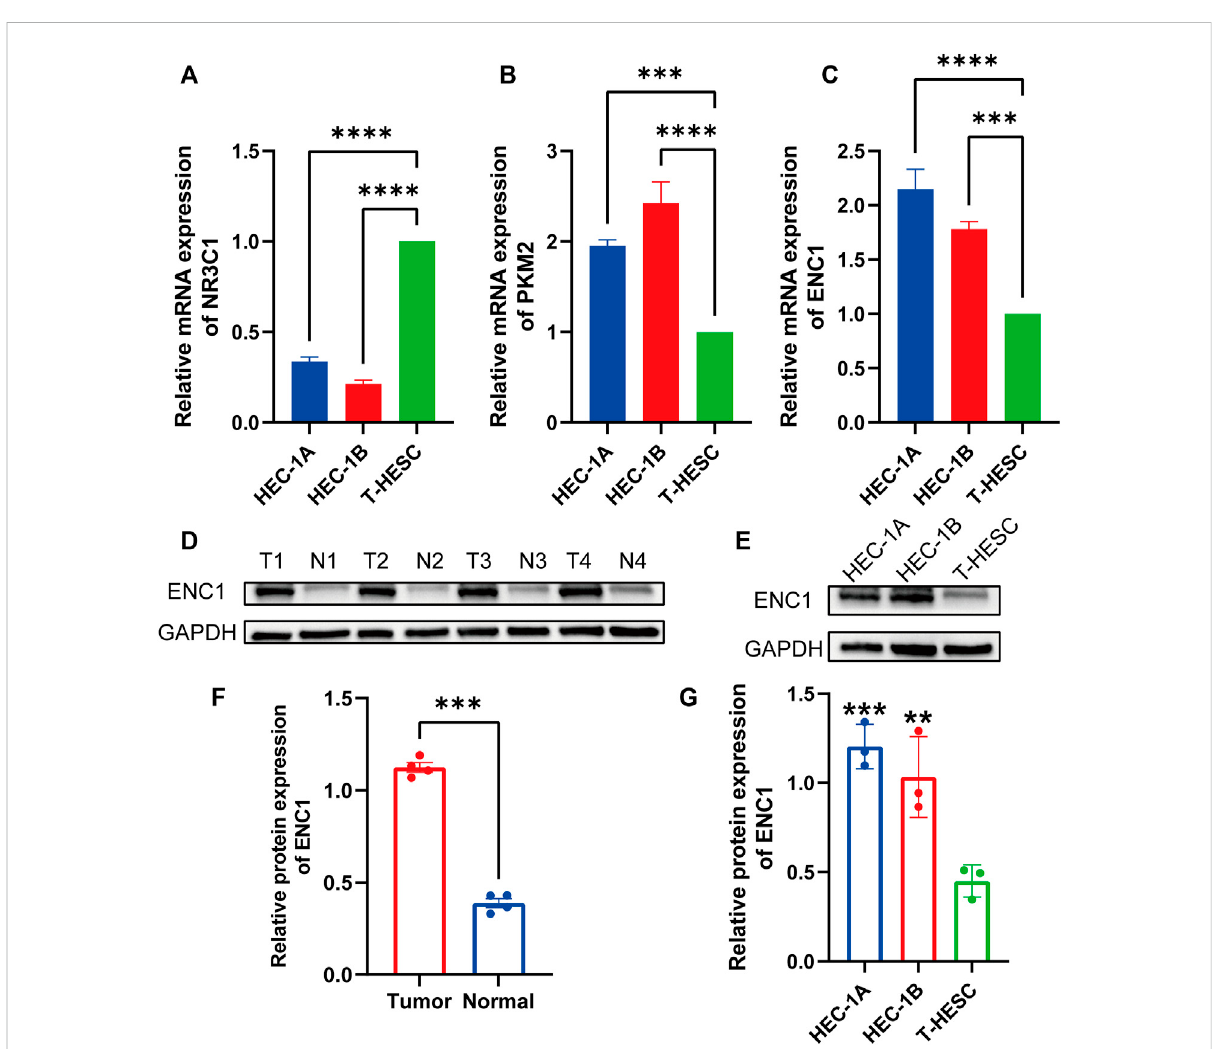
FIGURE 7 Validation of hub gene expression levels by quantitative real-time PCR and Western blotting. (A) The expression level of NR3C1 mRNA in endometrial cancer cell lines (HEC1A, HEC1B) was signi fi cantly lower than that in normal endometrial tissue cell lines (T-HESC). (B) PKM2 mRNA expression levelsweresigni fi cantlyhigherinendometrialcancercelllines. (C) ENC1mRNAexpressionlevelsweresigni fi cantly higherinendometrial cancer cell lines. (D) Western blot analysis of ENC1 protein expression in endometrial cancer tumor and adjacent normal tissues. (E) Western blot analysis of ENC1 protein expression in endometrial cancer cell lines (HEC-1B and HEC1B) and normal endometrial tissue cell lines (T-HESC). (F) Histogram showed that the protein expression of ENC1 in endometrial carcinoma was signi fi cantly higher than that in normal tissues. (G) The histogram showed that the protein expression of ENC1 in two endometrial cancer cell lines was signi fi cantly higher than that in normal endometrial tissue cell lines. ** p < 0.01; and *** p < 0.001; **** p <